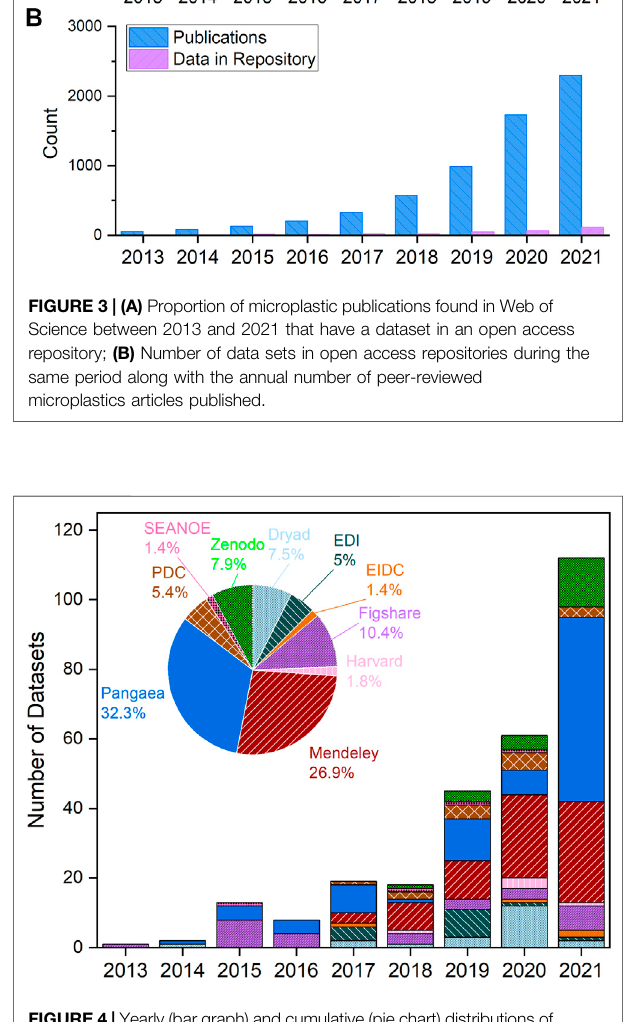
FIGURE 4 | Yearly (bar graph) and cumulative (pie chart) distributions of microplastics datasets uploaded to open access repositories between 2013 and 2021.